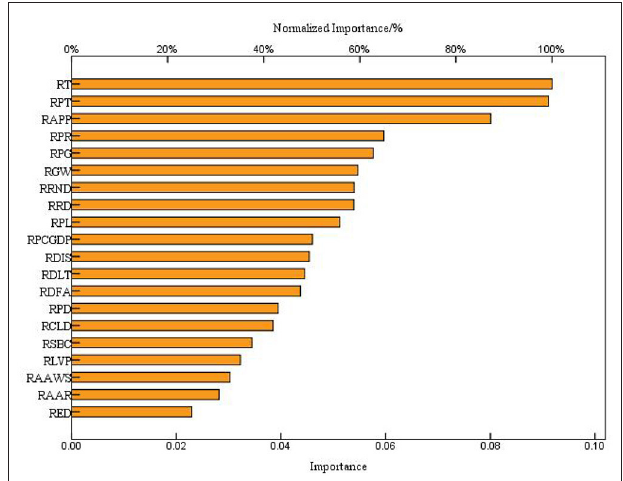
FIGURE 7 | The importance of the contribution rate of BP–ANN input neurons to output variables.